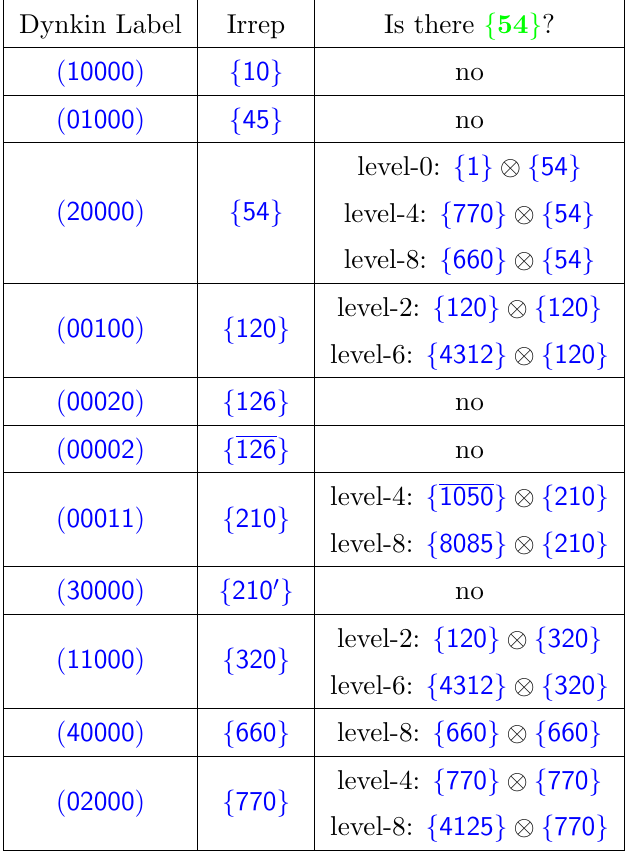
Table 6 . Summary of tensoring bosonic irreps onto the scalar